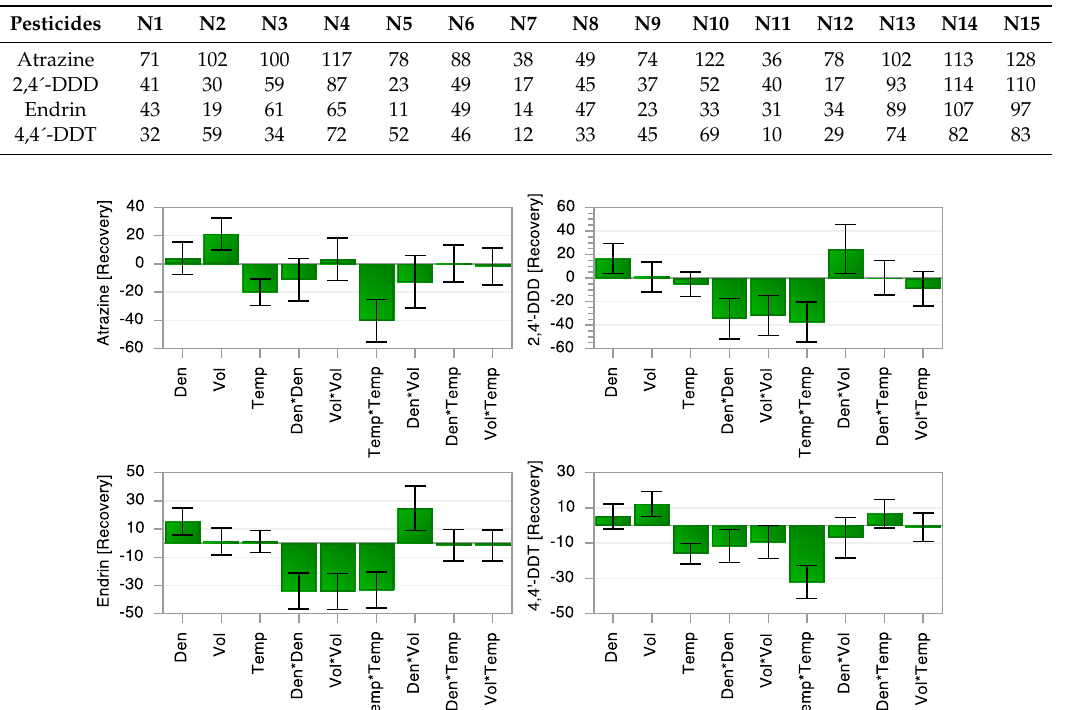
Figure 2. Effect of extraction variables and their interactions on the recovery (%) of analytes. Den, Vol and Temp represent density, volume and temperature, respectively.